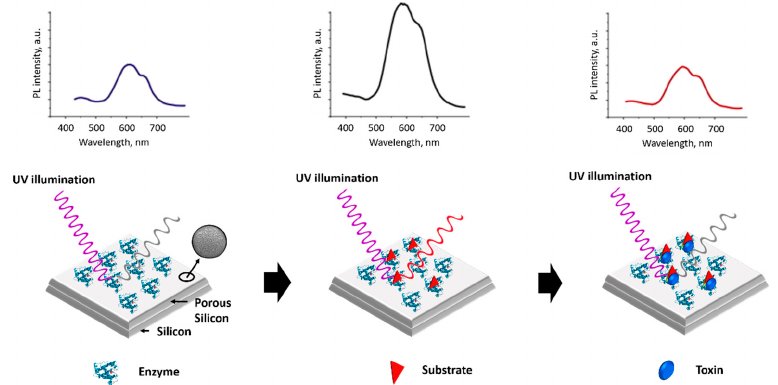
Figure 7. Schematic diagram of luminescent biosensors based on glucose oxidase or urease for the detection of glucose, urea, and heavy metals. Adapted from [112].